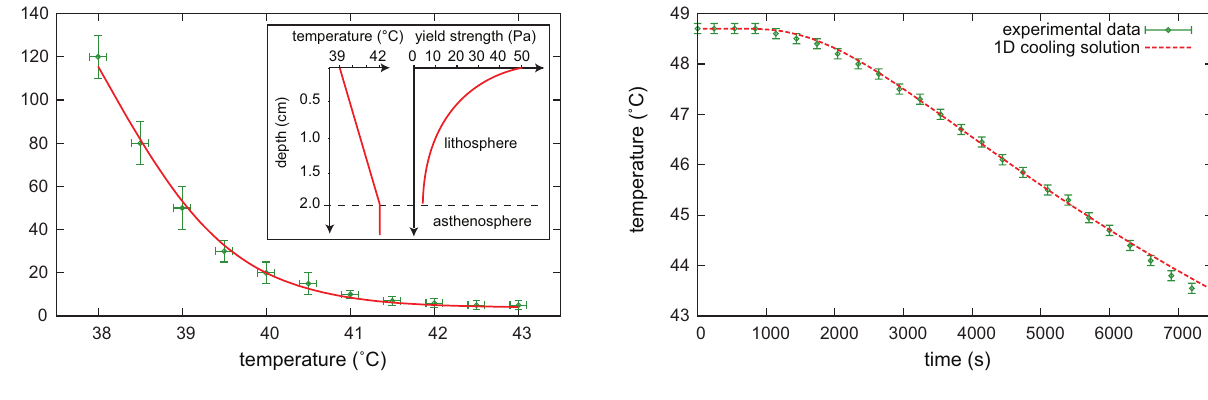
Fig. 4. Evolution of the plastic yield stress with temperature. The plastic yield stress decreases with increasing temperature. Inset: Once the temperature gradient in the model lithosphere is known, the experimental curve is used to draw the strength envelop of the model lithosphere prior to deformation.